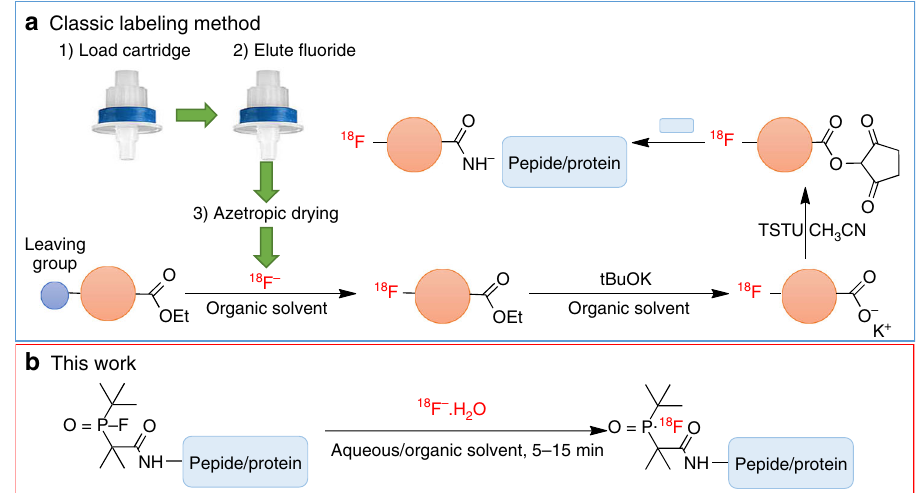
Fig. 1 Overview of 18 F-labeling methods for solvent/heat-sensitive biomolecules. a Commonly used multistep synthetic route beginning with drying of aqueous [ 18 F]F − . b One-step 18 F-labeling of biomolecules via an organophosphine fl uoride acceptor that allows for ef fi cient labeling with good RCYs (>50%) under mild conditions within 5 – 15